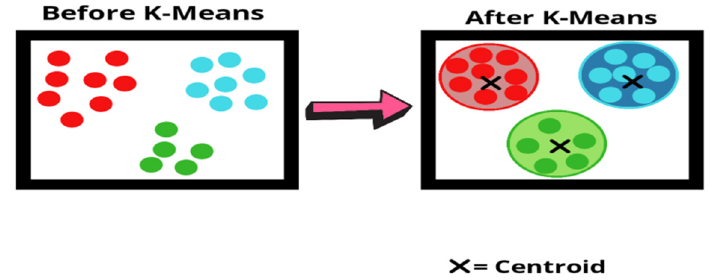
Figure 2. K-means clustering approach.